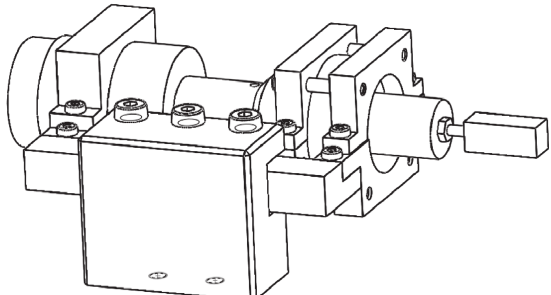
Figure 5: Special fixture structure for ultrasonic vibration